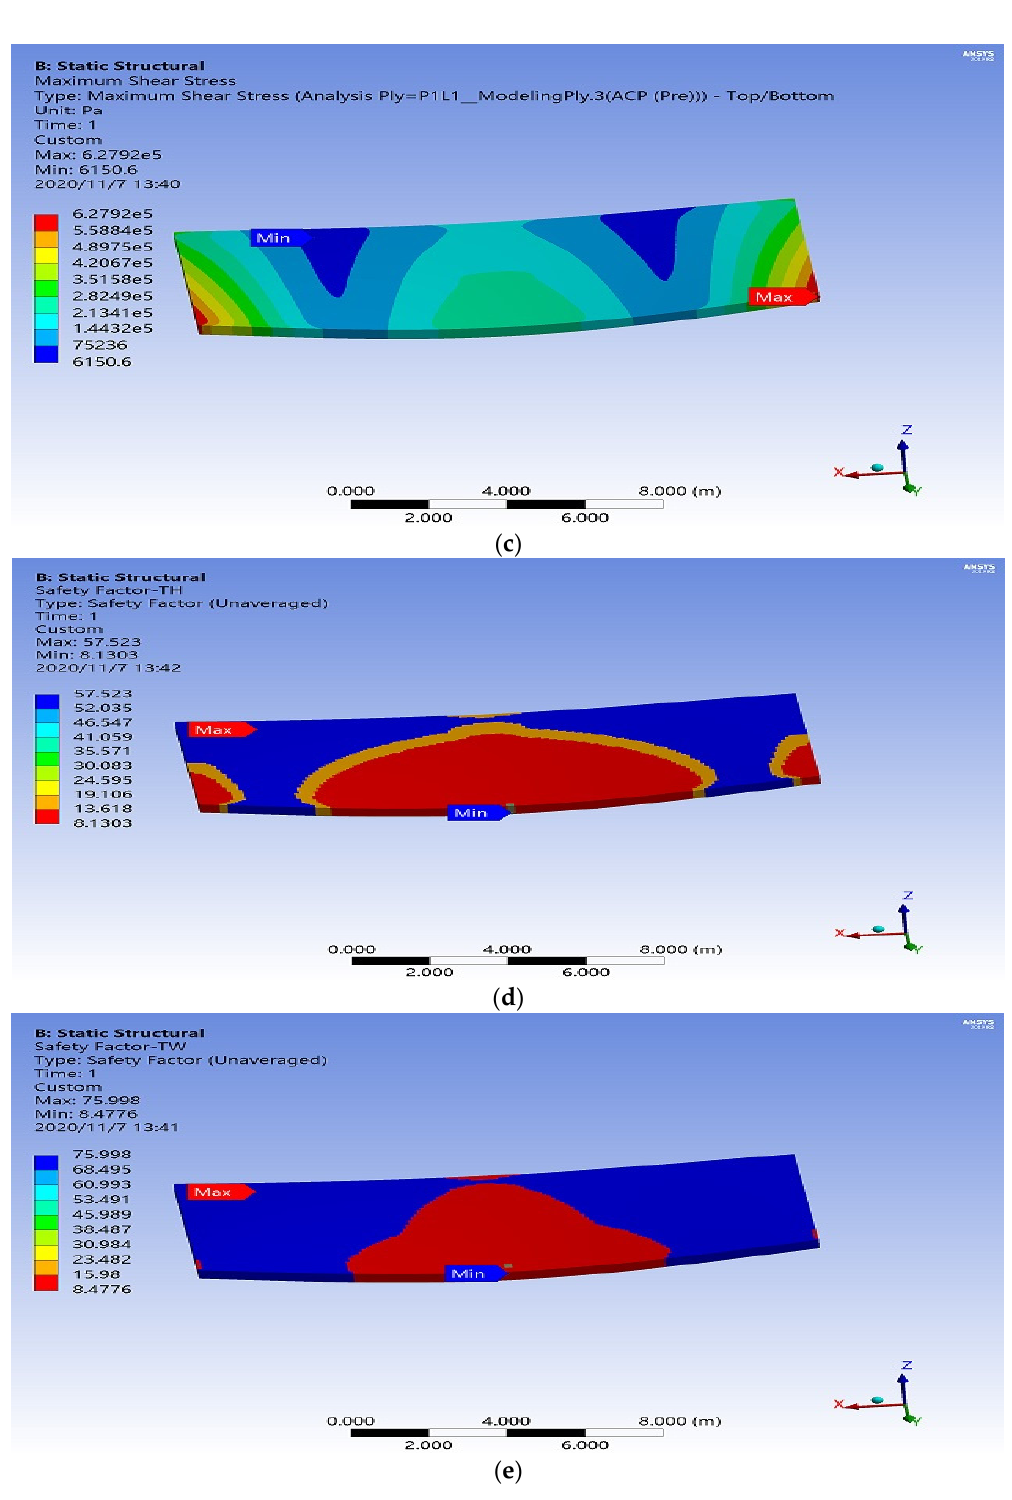
Figure 2. ( a ) Directional deformation; ( b ) Equivalent stress; ( c ) Maximum shear stress; ( d ) Tsai-Hill safety factor; ( e ) Tsai-Wu safety factor.